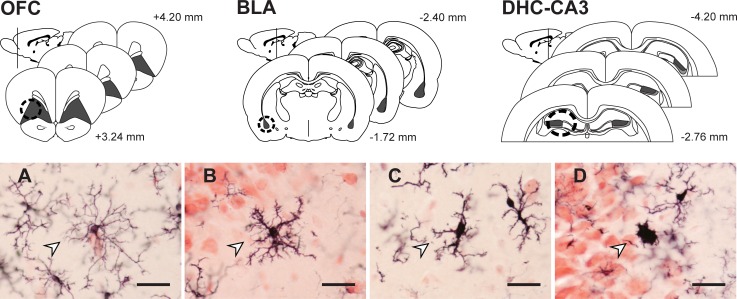
Corticolimbic sampling and microglial cell morphology.Stereological estimates (shaded in grey) and micropunch samples (dashed circle, indicated in one hemisphere for simplicity) were derived from both hemispheres of OFC, BLA, and DHC (CA3 stratum radiatum, dark grey; CA3 stratum oriens, light grey) using standard gross morphology (micropunch) and cytoarchitecture (stereology) [45]. Microglia were classified as A) surveillant (numerous thin processes, radial branching); B) primed (thickened processes, increased polarity, proliferation, some reduced secondary branching); C) reactive (thickened stout processes with highly reduced branching); or D) amoeboid (few-to-no processes, enlarged cell body). Scale bars = 10 μm. Arrowheads indicate exemplars of each type.